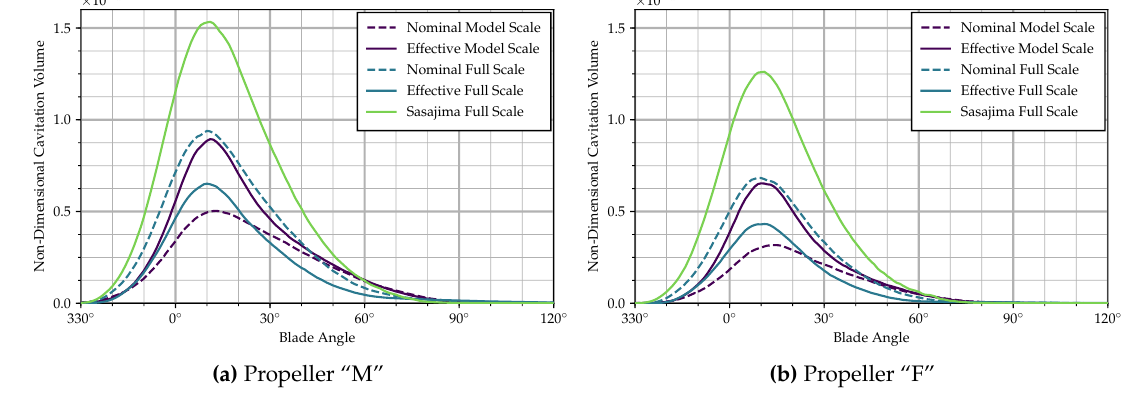
Figure 4. Cavitation volume.